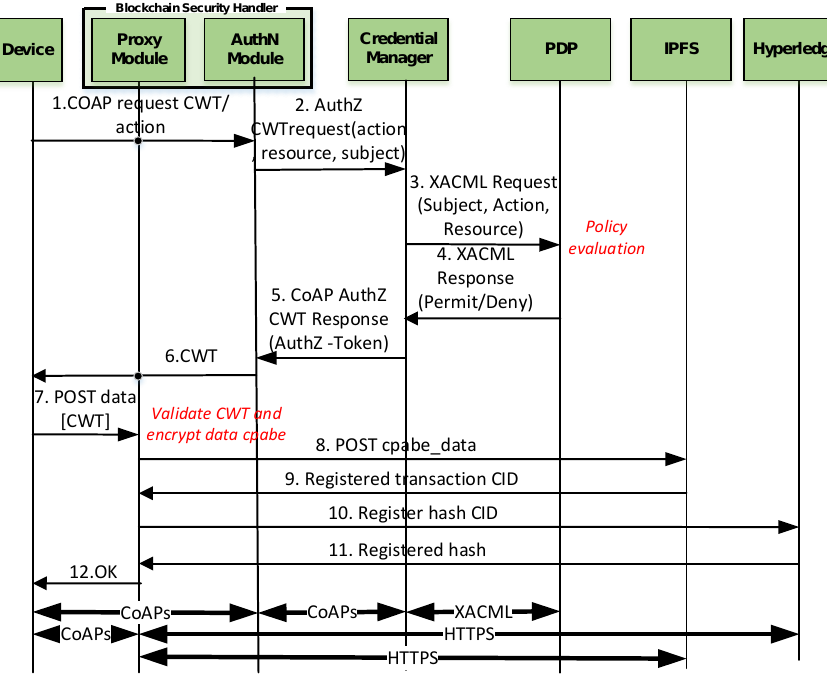
Figure 3. Message exchange of post-bootstrapping phase.